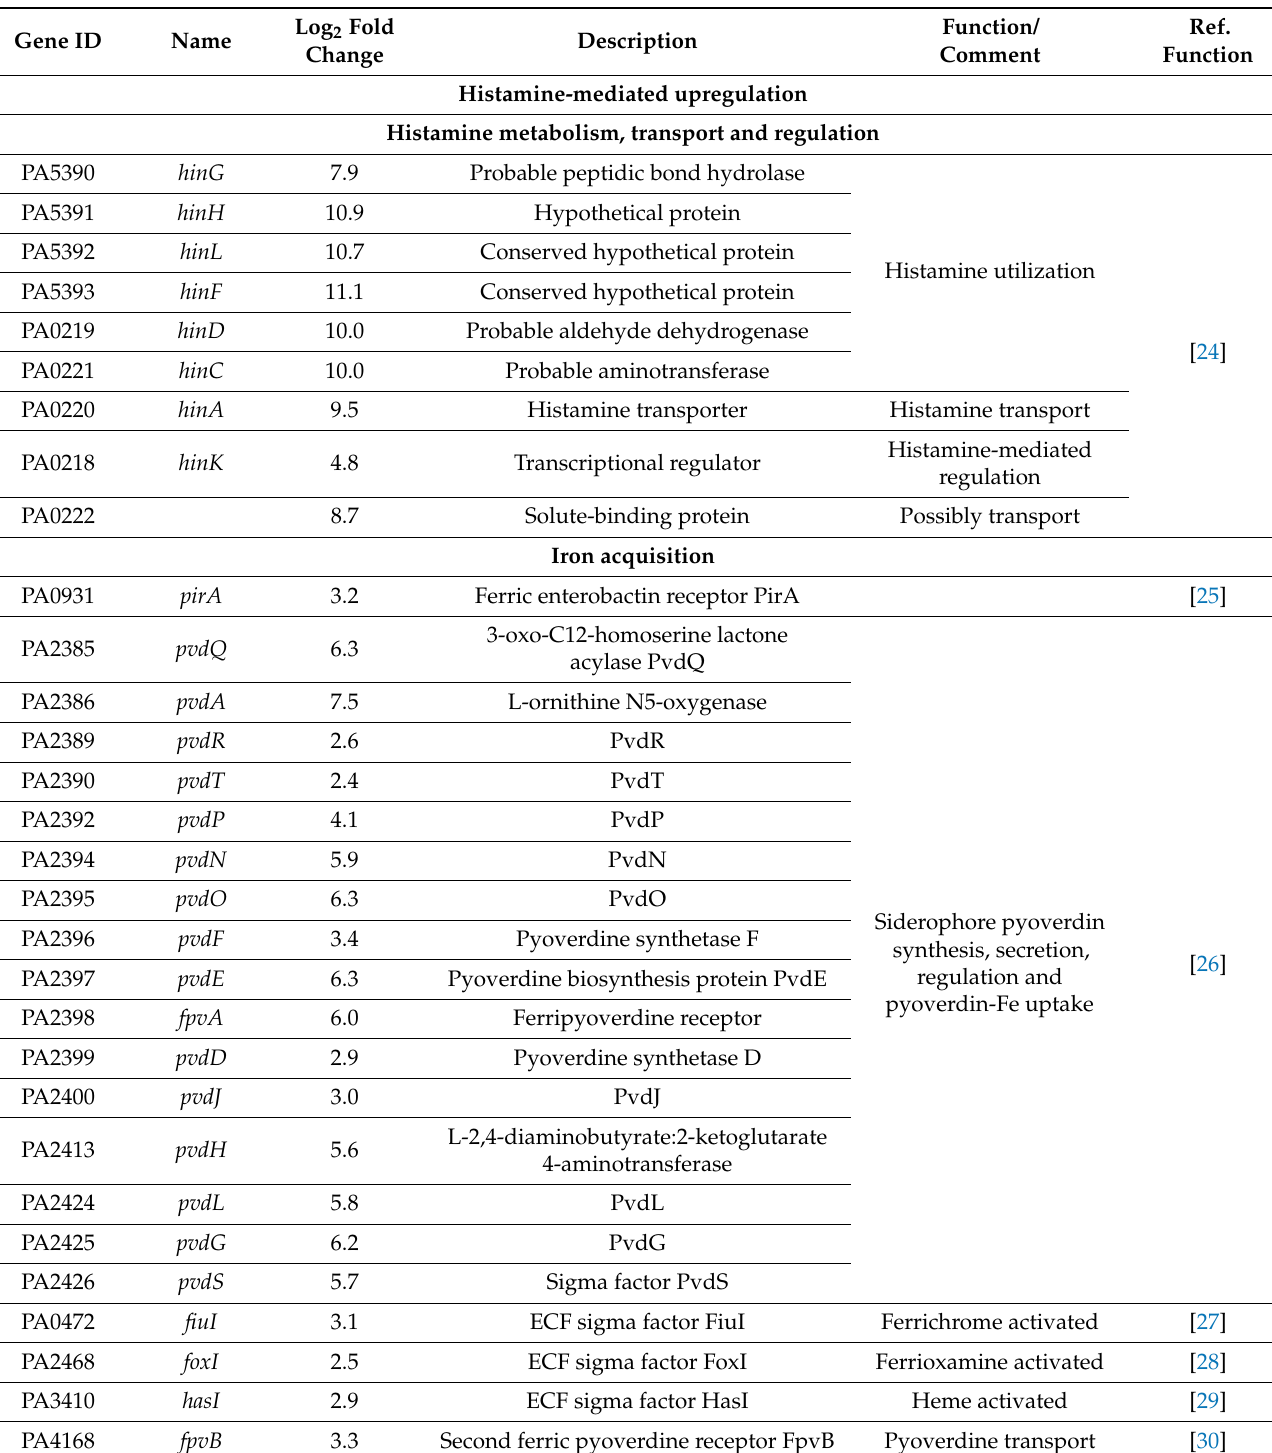
Table 1. The effect of histamine on P. aeruginosa PAO1 transcript levels. Shown is a selection of genes with altered transcript levels in an RNA-seq study comparing the wt strain in the absence and presence of 2 mM histamine. Many of these genes play a role in virulence. In total, approximately 8.5% of the P. aeruginosa genes showed at least a three-fold change. Data were taken from